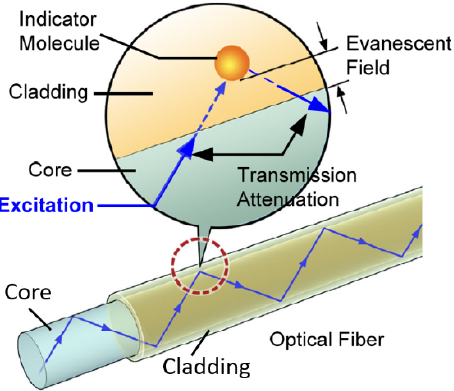
Figure 15. Schematic of evanescent field-based chemical sensor with a colorimetric indicator contained in the cladding of optical fiber [118].